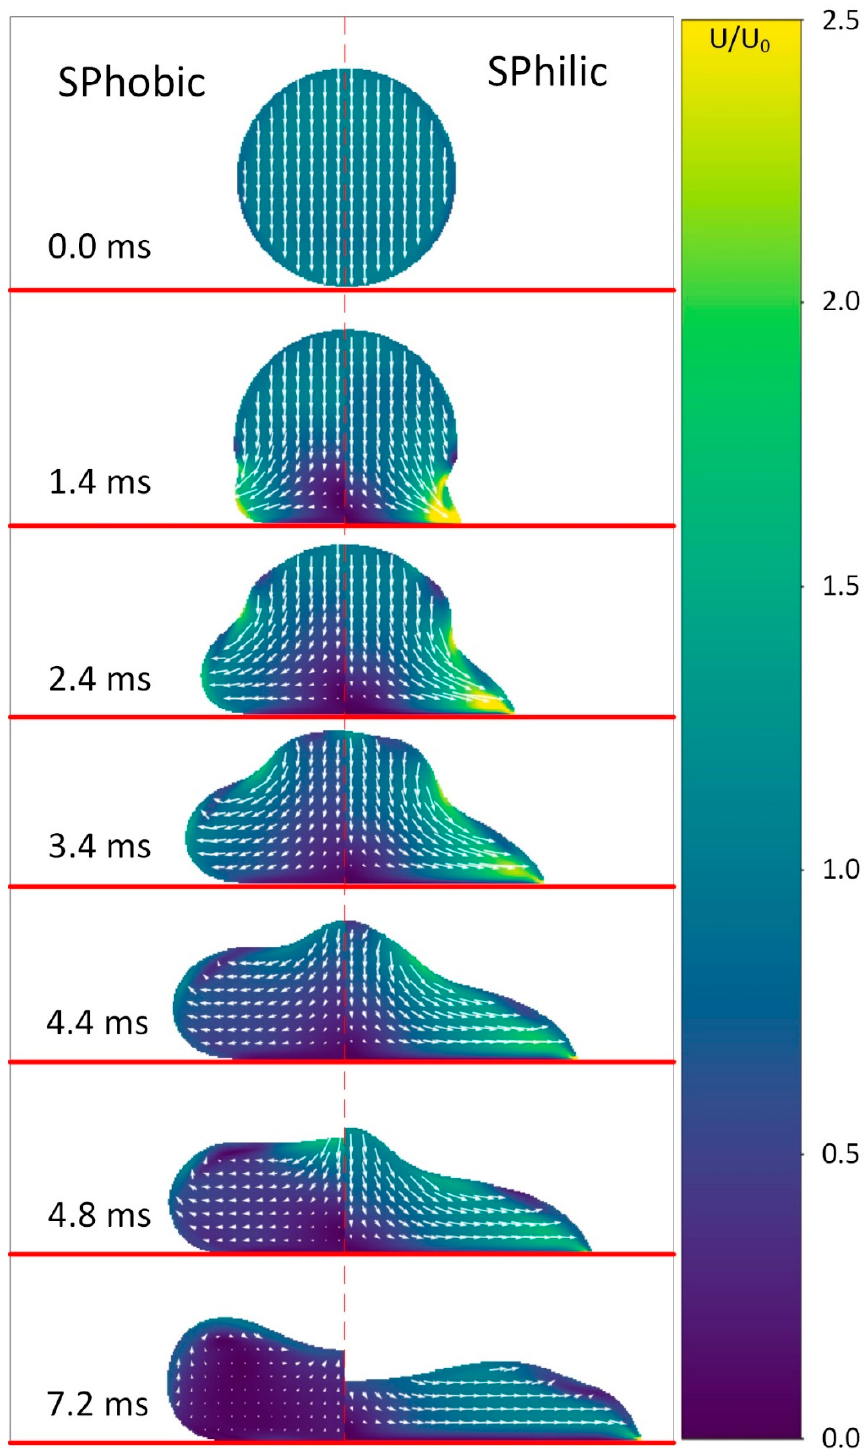
Figure 7. Velocity field in the droplet with D 0 = 2.9 mm falling on the superhydrophobic and superhydrophilic surfaces at We = 3.